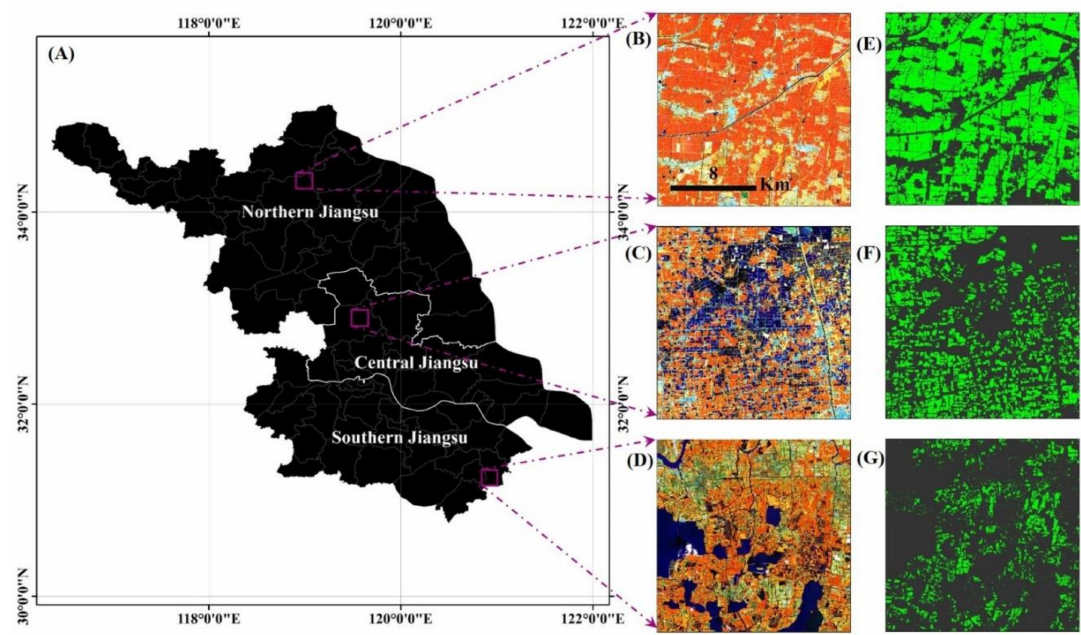
Figure 14. ( A ) Rice classification with OCSVC for the three representative county sites in Jiangsu Province, China. Subfigures ( B – D ) are Landsat image composites (R: NIR, G: SWIR1, B: Red) for the sites in Shuyang (Northern Jiangsu), Gaoyou (Central Jiangsu), and Kunshan (Southern Jiangsu) at the peak growth stage of rice. Subfigures ( E – G ) are classification maps for the three sites. All subfigures are displayed at the same scale (18 km × 18 km). The center coordinates of those three sites are (34 ◦ 18 (cid:48) 39.95”N, 118 ◦ 59 (cid:48) 36.98”E), (32 ◦ 53 (cid:48) 38.77”N, 119 ◦ 34 (cid:48) 17.26”E), and (31 ◦ 13 (cid:48) 37.30”N, 120 ◦ 55 (cid:48) 07.19”E), respectively.